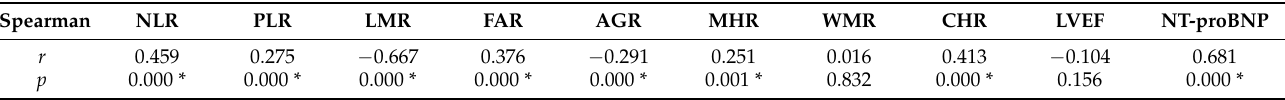
Table 5. Spearman correlation analysis of SII and NYHA functional classification.